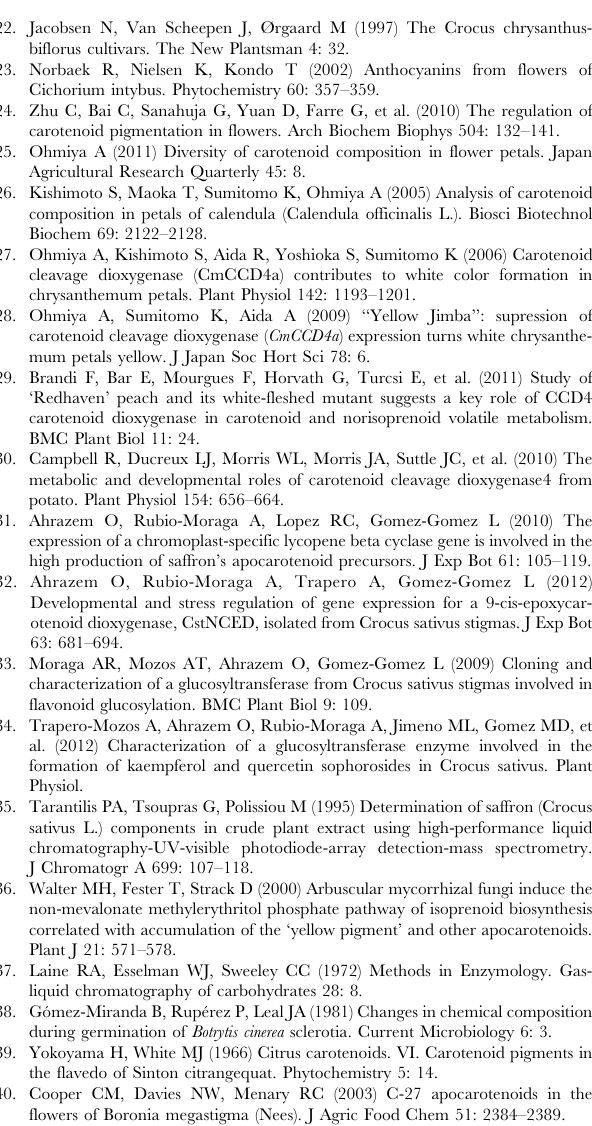
400 nm and below LC-PDA/UV isoplot chromatogram showing the compounds detected (200–550 nm). B, In the upper part the HPLC profile of anthesis stigma at 400 nm and below LC-PDA/ UV isoplot chromatogram showing all the compounds detected (200–550 nm). C, Representative HPLC chromatograms from aqueous extracts of C. ancyrensis stigma (black line) and C. sativus stigma (grey line) at 446 nm. Labels correspond to compounds shown in Table 1. The red and grey circles denoted the compounds with absorbance between 424–446 nm and 379– 399 nm, respectively. Figure S7 Presence of different types of apocarotenoids in the stigma extracts of several Crocus species. A. LC-PDA/UV isoplot chromatogram showing all the compounds detected (200–550 nm) of stigma aqueous extracts of different Crocus species with chromatographic method A. The red circles denoted the compounds with absorbance between 379–399. B. Absorbance spectrum of non- crocin apocarotenoids detected in the stigmas of C. ancyrensis .